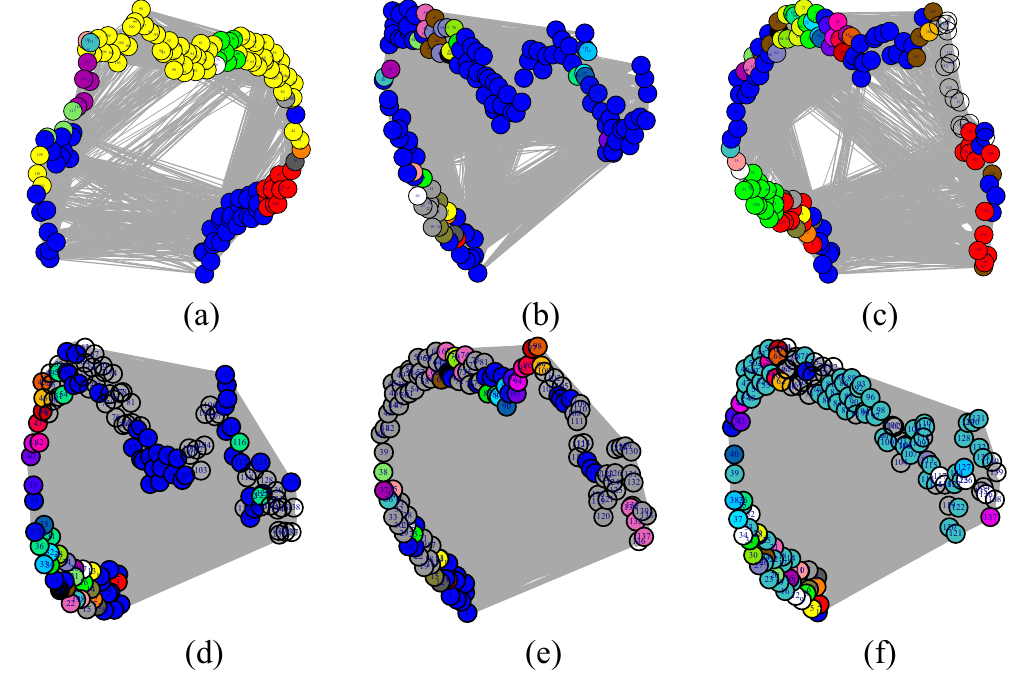
Figure 5. The structure network of ( a ) WT-human, ( b ) G51D-slow, ( c ) E46K-fast, ( d ) H50Q, ( e ) A53T and ( f ) A30P models.